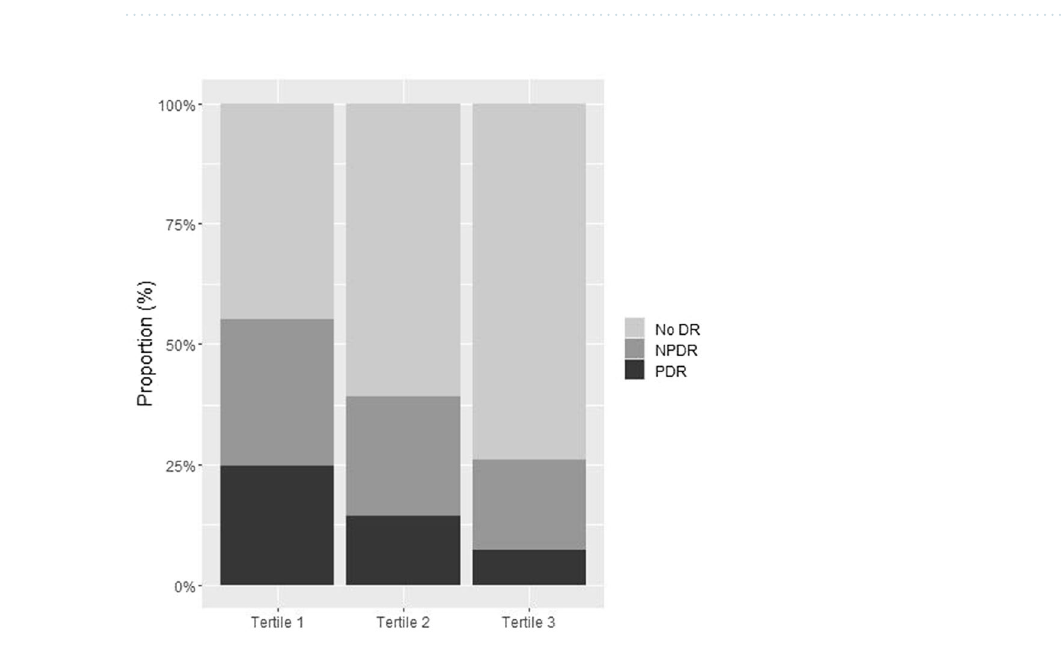
Association between diabetic retinopathy and GNRI. We performed multivariate logistic regression analyses and NPDR and PDR were considered as dependent variables (Table 3). Longer duration of diabetes (Odds ratio (OR) 1.100, 95% Confidence Interval (CI) 1.070–1.132, P < 0.001), higher HbA1c (OR 1.289, 95%